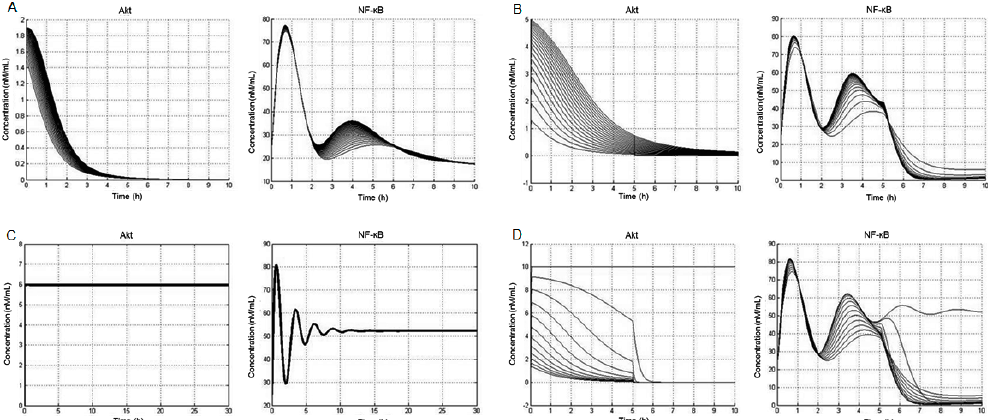
Figure 4. Computer simulation of the alteration in the PI3K-Akt pathway and its effects on Akt activation and nuclear NF- κ B concentrations. In silico simulation of ( A ) epidermal growth factor receptor (EGFR) overexpression. The concentration of EGFR varied between 80 and 360 nM as the nominal value. The system was then stimulated with 360 nM EGF for 10 h. ( B ) PI3K overexpression. The concentration of PI3K varied between 10 and 100 nM as the nominal value. The system was then stimulated with 10 nM EGF for 5 h. ( C ) PTEN loss was modeled by eliminating the dephosphorylation of PIP3. The system was then stimulated with 10 nM EGF for 5 h. ( D ) PP2A mutation/loss was modeled by varying the concentration of PP2A between 0 and 11 nM as the nominal value. The system was then stimulated with 10 nM EGF for 5 h. Details are provided in the Materials and Methods section.